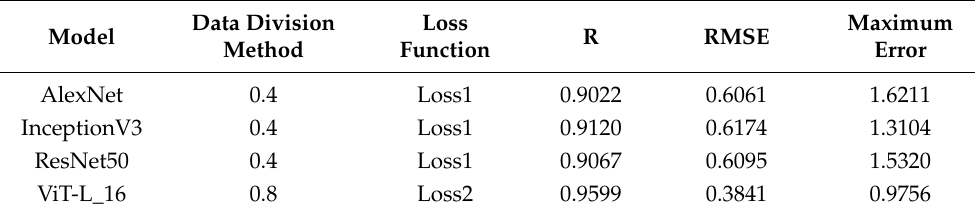
Table 3. Comparison of the best results for the typical convolutional neural network and visual transformer